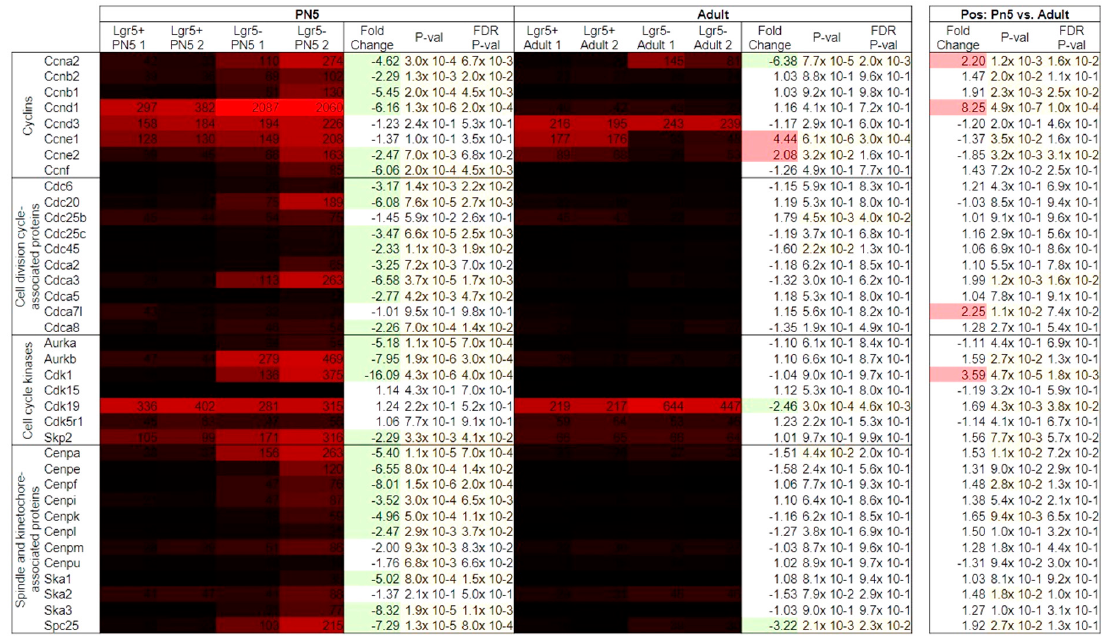
Figure 2. Gene expression levels and fold changes of cell cycle markers. Fold change describes downregulated cell cycle genes at PN5 in Lgr5 + cells compared to Lgr5 − cells. Differentially expressed genes were defined by a fold change ≥ 2 or ≤ − 2, p -value < 0.05, and false discovery rate (FDR) < 0.05. Lgr5 is part of the Wnt signaling cascade. Yet, the only overrepresented GO term related to Wnt signaling in the PANTHER analysis was “negative regulation of canonical Wnt signaling pathway” (FE: 3.51, p = 2.3 × 10 − 5 ; Supplementary Table S5). The gene expression levels of members of the